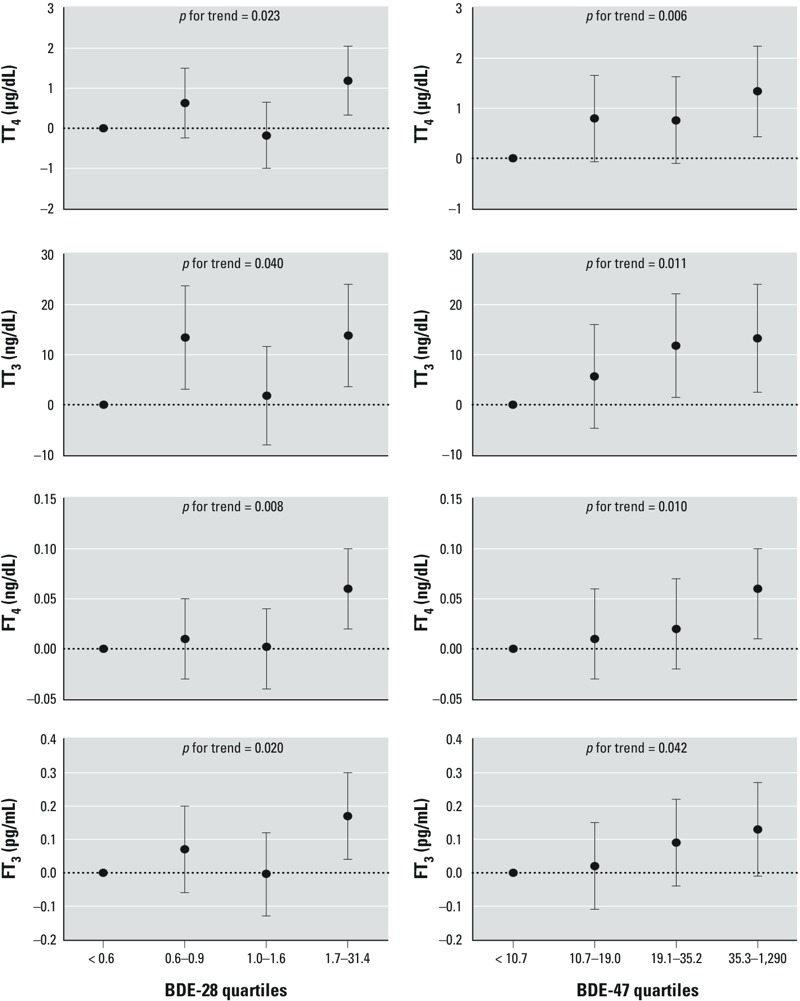
β-coefficients and 95% CIs from regression models for associations of BDE-28 and BDE-47 (ng/g lipid) quartiles and maternal thyroid hormones. All models adjusted for maternal age, race/ethnicity, education, parity, family income, smoking status, alcohol consumption, gestational age at serum collection, and total serum PCB concentrations. p-Value for trend was obtained by using the median value in each quartile as a continuous variable in the linear regression models.